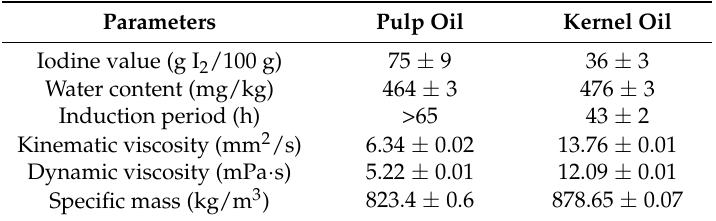
Table 2. Physicochemical parameters of pulp and kernel oils from A. aculeata .